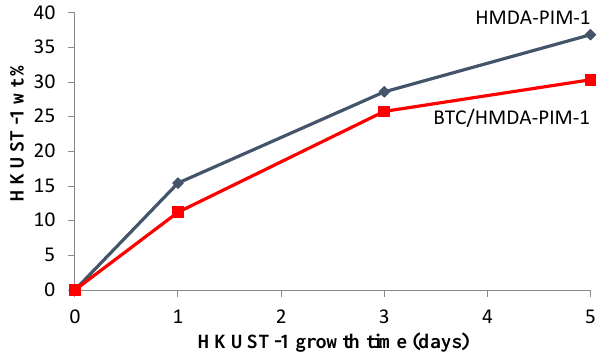
Figure 2. Amount of zeolitic imidazolate framework-8 (ZIF-8) deposited with increasing number of growth cycles on HMDA-PIM-1 ( ), AMD-PIM-1 ( ) and neat PIM-1 membranes ( ).